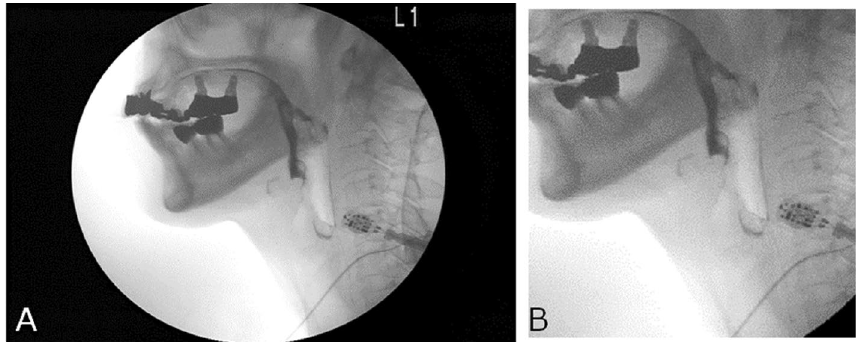
Figure 2. Image preparation. ( A ) A static image converted from videofluorography video images. The image size is 720 × 480 pixels. ( B ) The image was standardized to a size of 256 × 256 pixels by cutting off extra space at the top and front of the original image, then converted to JPEG